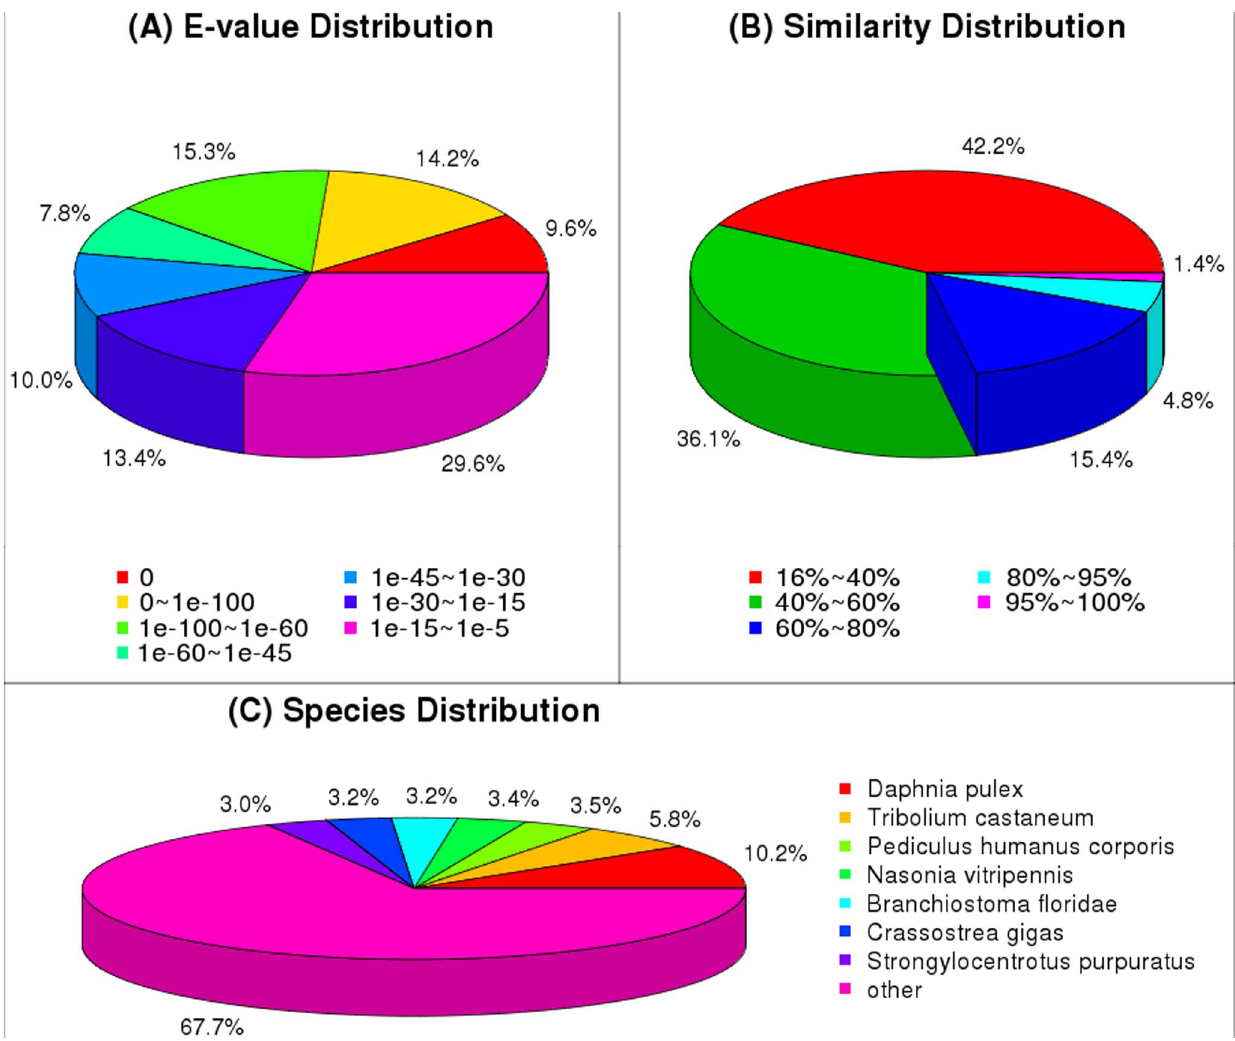
Figure 2. Characteristics of homology search of 454 sequences against nr database. (A) E-value distribution of BLAST hits for each unique sequence with a cut-off E-value of 1.0E-5. (B) Similarity distribution of the top BLAST hits for each sequence. (C) Species distribution shown as a percentage of total homologous sequences with E-value of $ 1.0E-5.